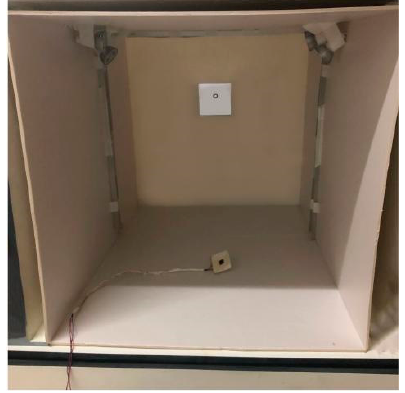
Figure 3. The test box part of the experimental device.